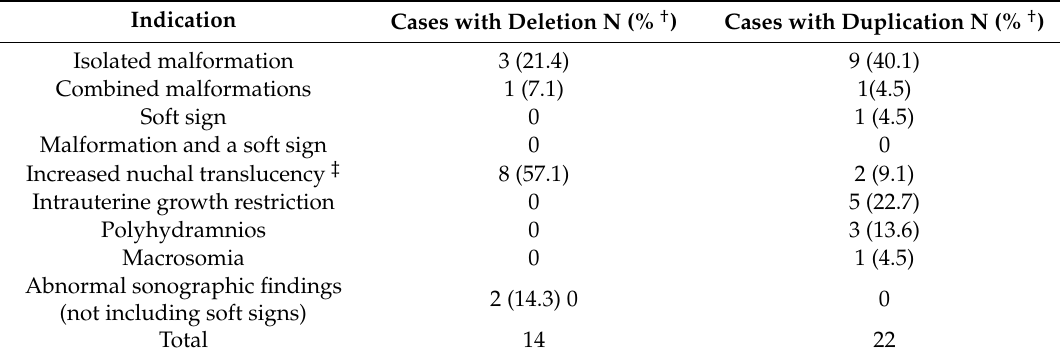
Table 2. Indications for CMA testing in prenatally detected 15q11.2 BP1-BP2 copy number variations.